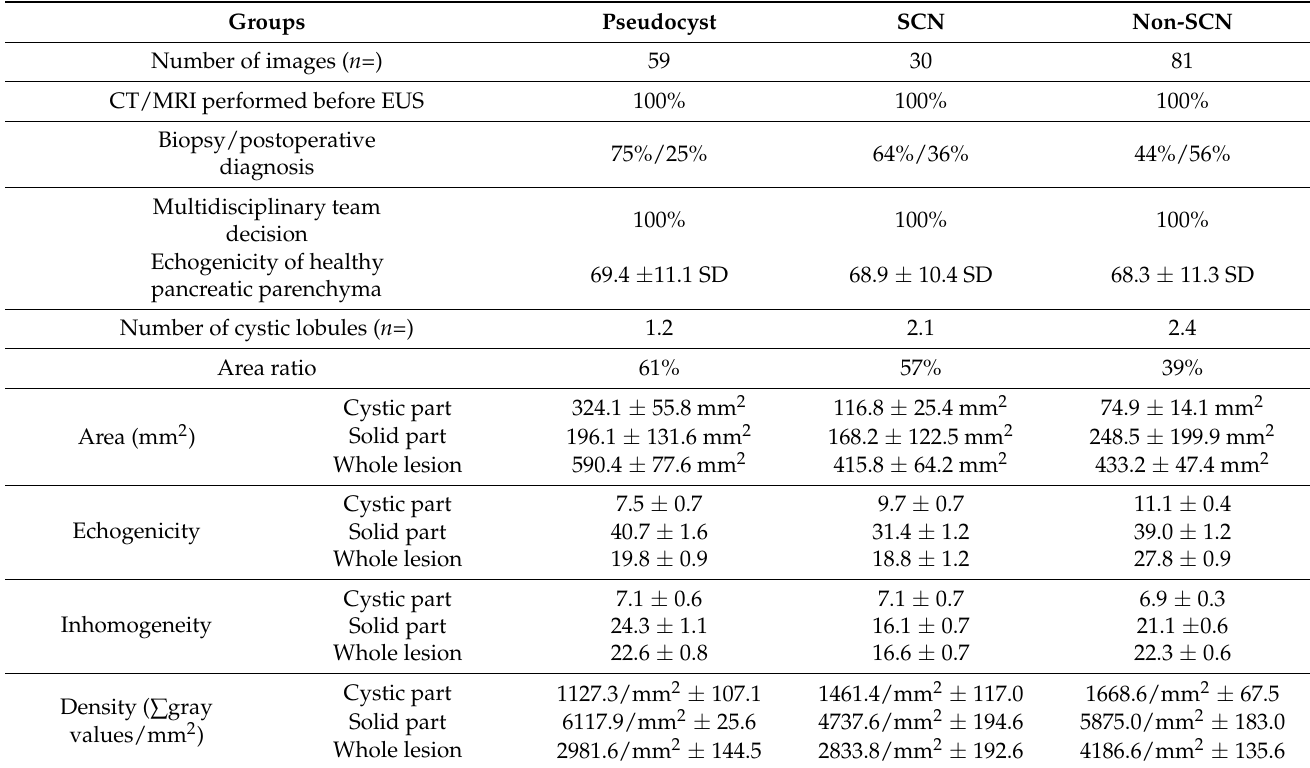
Table 1. Groups and